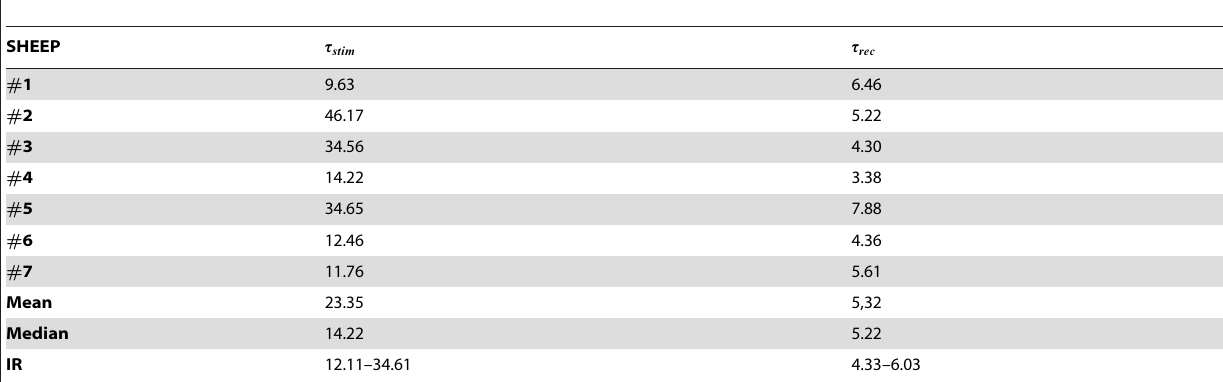
Table 1. Time constants of the fRR-response to UCO (in seconds).